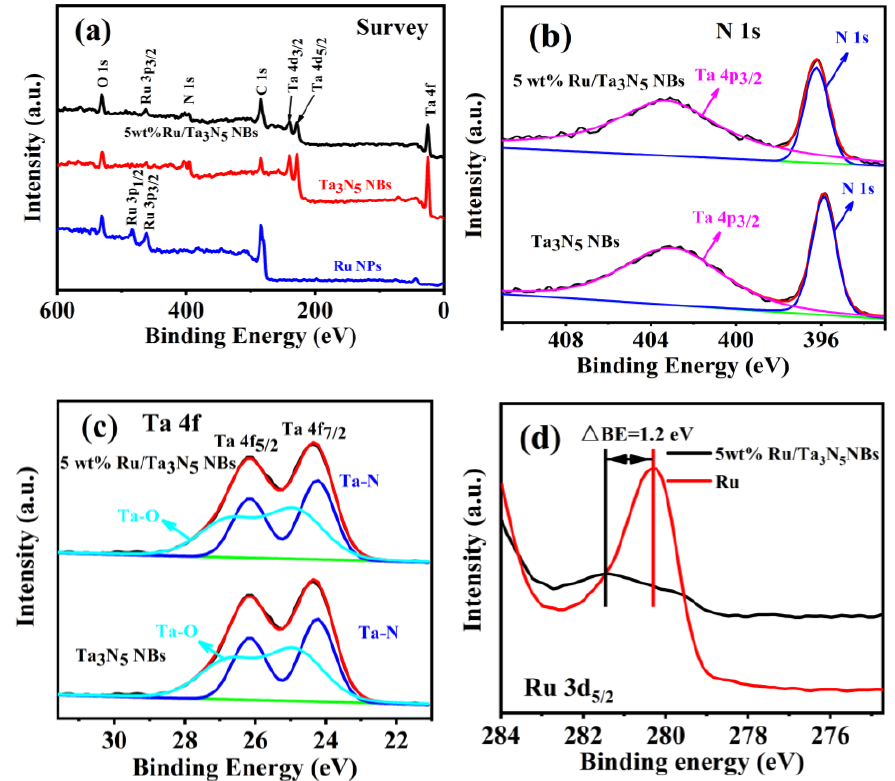
Figure 4. XPS spectra of Ta 3 N 5 , 5 wt% Ru/Ta 3 N 5 , and Ru. ( a ) Survey, ( b ) N 1s, ( c ) Ta 4f, and ( d ) Ru3d 5/2 .